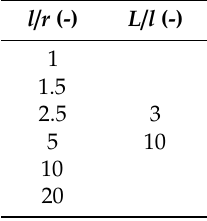
Table 2. Parametric study ( r is the radius of the cylindrical electrodes, l is the penetrated depth of the cylindrical electrodes, L is the distance between two cylindrical